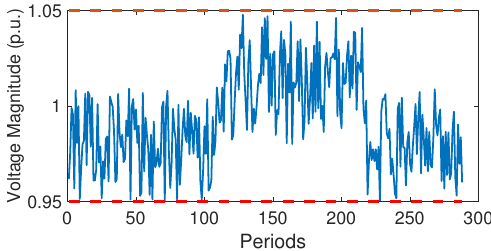
Figure 2. The blue line shows the variation of the magnitude of voltage when we implement our algorithm. The red lines show the acceptable